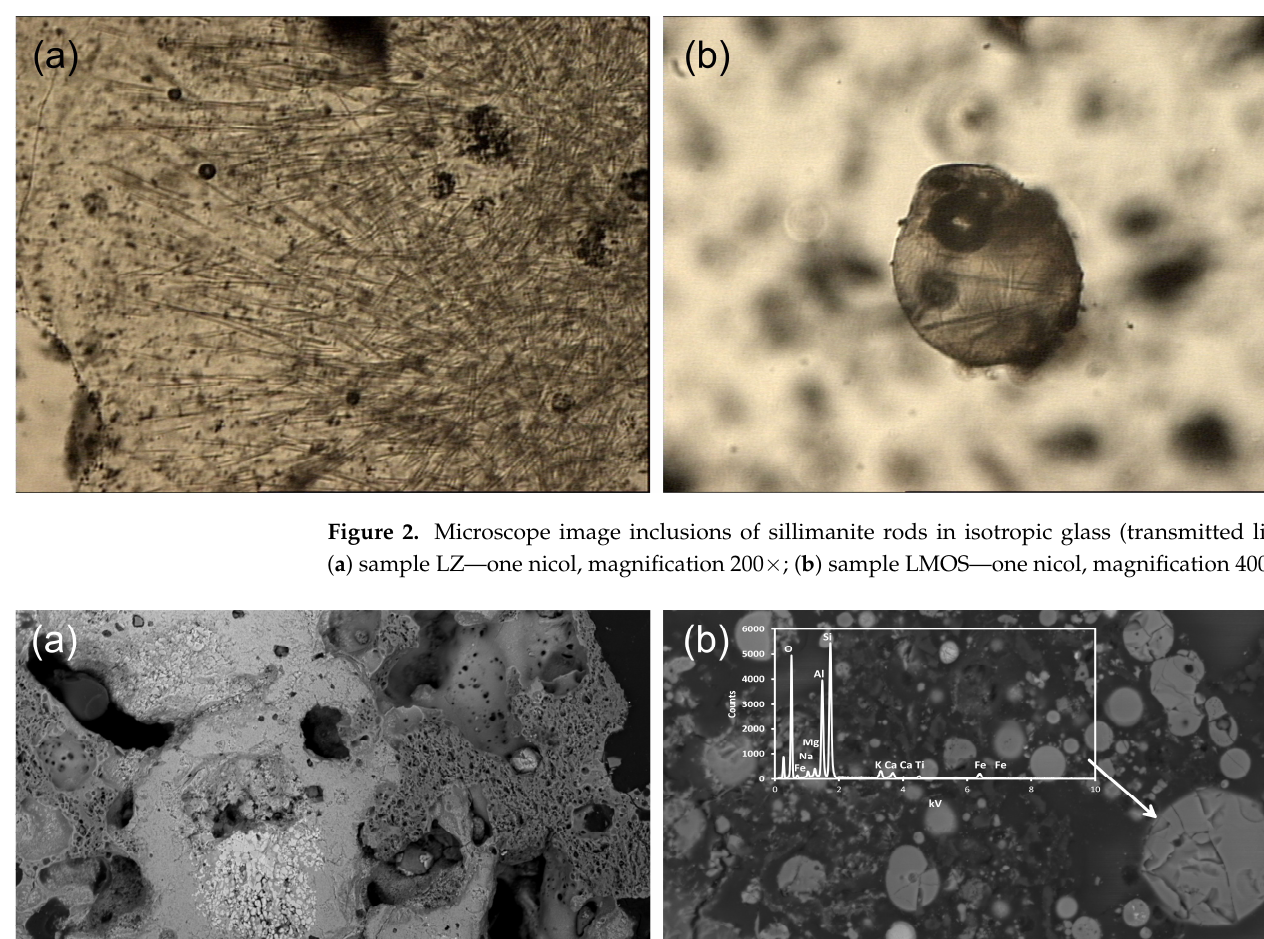
Figure 1. X-ray diffraction pattern of samples (the arrows indicate the basic phase reflexes).